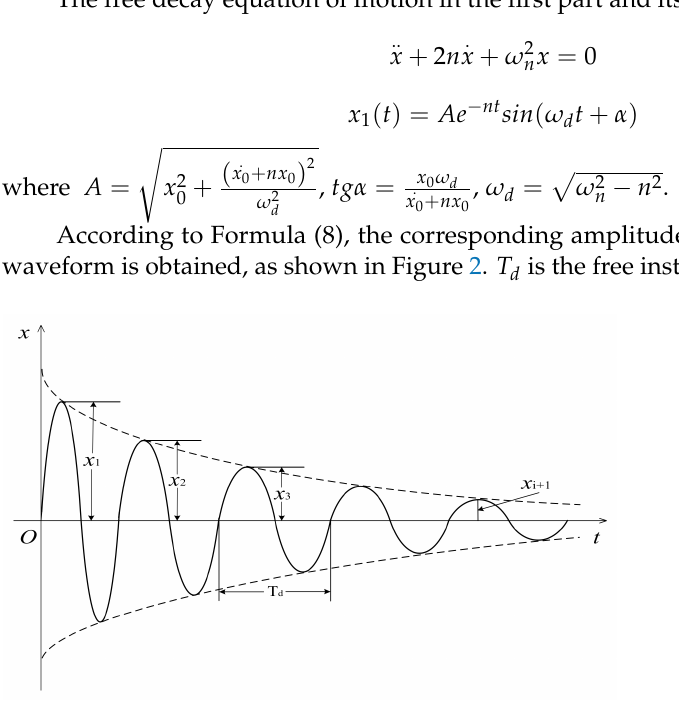
Figure 2. Freely attenuated vibration